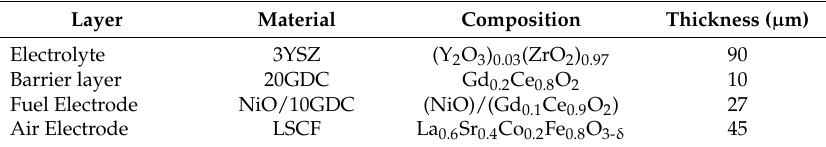
Figure 1. Schematic representation of the Sunfire MEA with its functional layers. Table 1. List of the cell layers with their composition and nominal thickness.